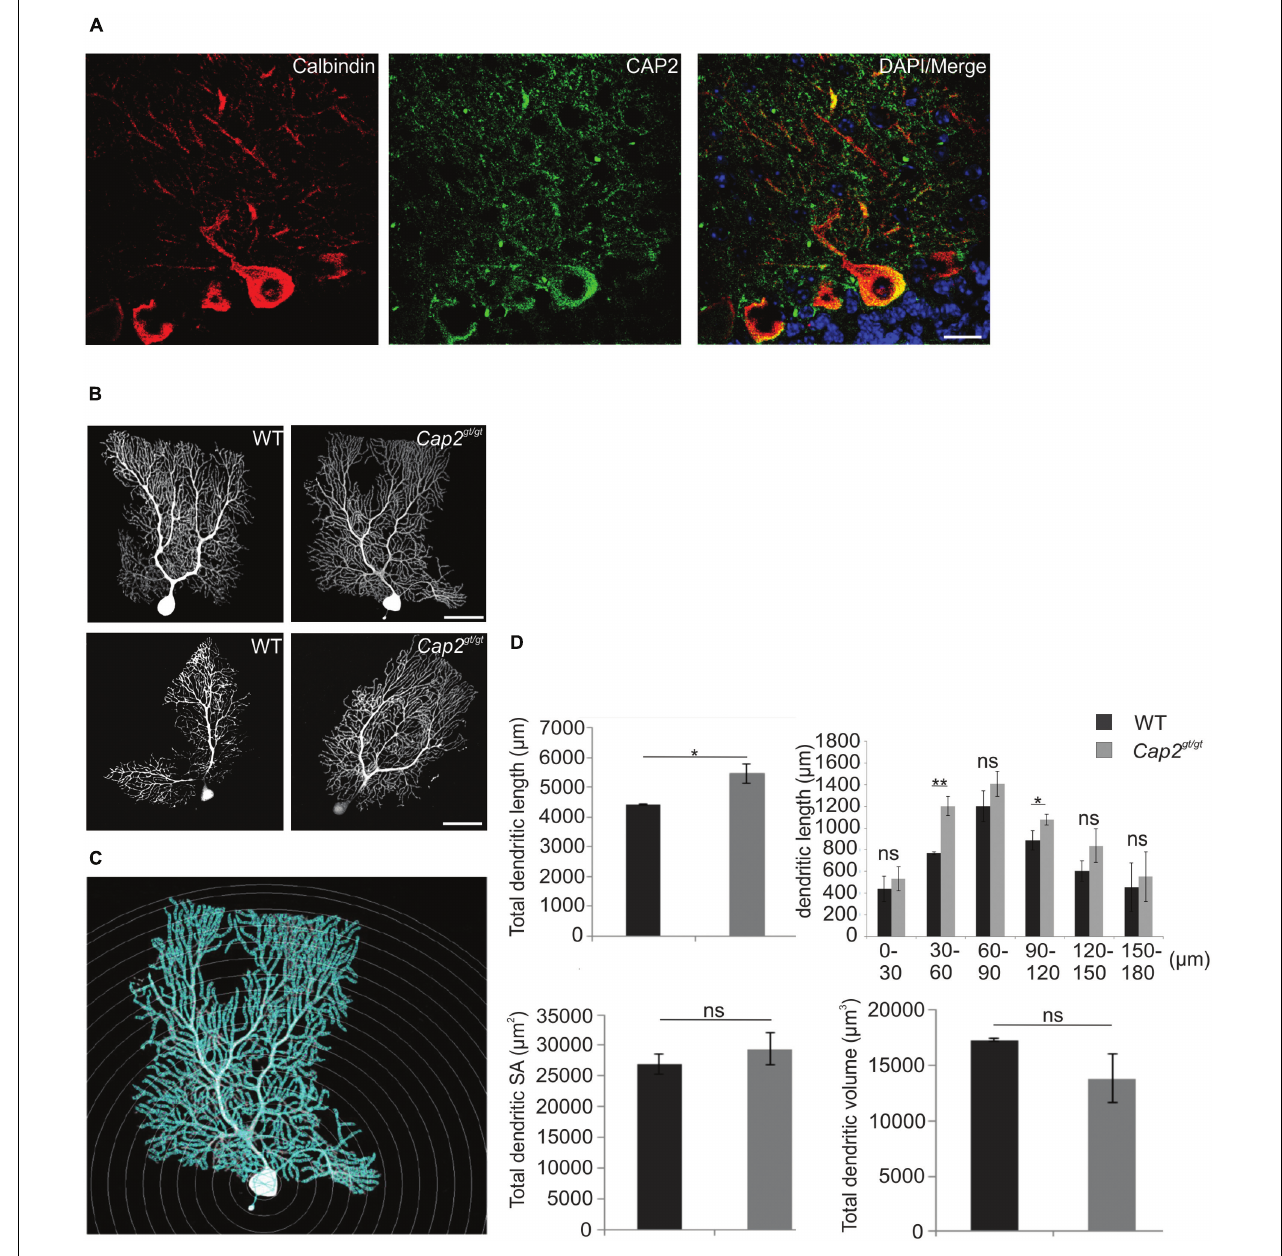
FIGURE 5 | Dendritic complexity is altered in mutant Purkinje neurons. (A) CAP2 (green) shows diffuse distribution in the cytoplasm and dendrites of Purkinje neurons labeled with antibodies against calbindin (red). Scale bar 20 µ m. (B) Purkinje neuron in cerebellum was injected with fluorescent dye biocytin at P60 (Upper panel) and P365 (lower panel) to evaluate neuronal complexity and morphology in CAP2 mutant mice. (C) Sholl analysis using NeuronStudio was performed for P60. Scale bar, 20 µ m. (D) Quantification of Sholl analysis for Purkinje neurons revealed an increase in total dendritic length but not in dendritic surface area and dendritic volume. ∗ p < 0.05, ∗∗ p <